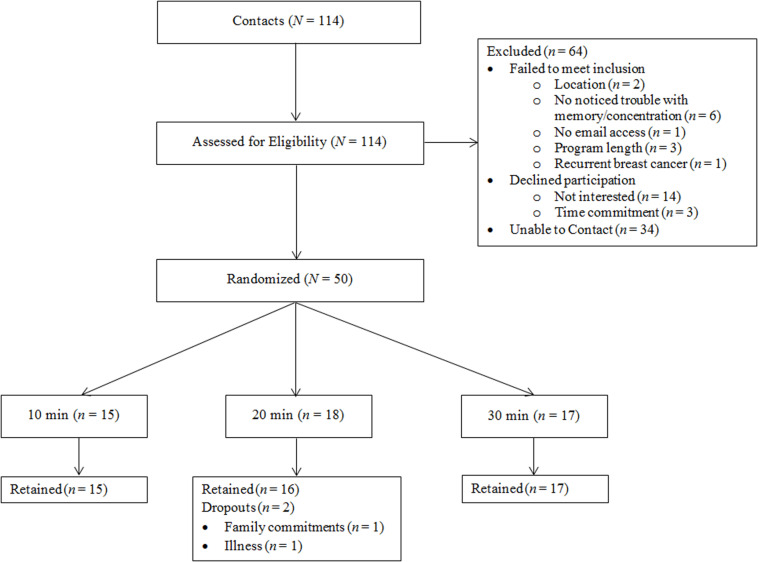
Participant flow through the study.